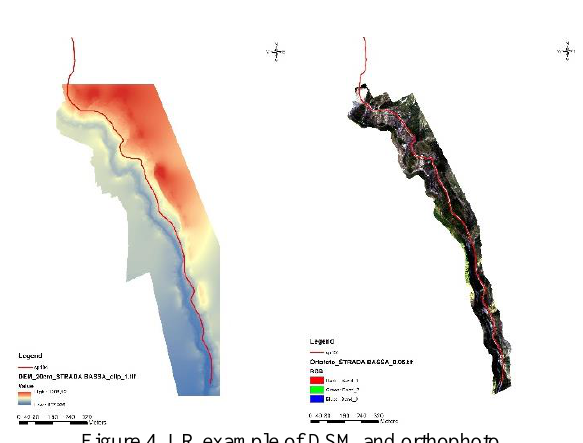
Figure 4. LR example of DSM and